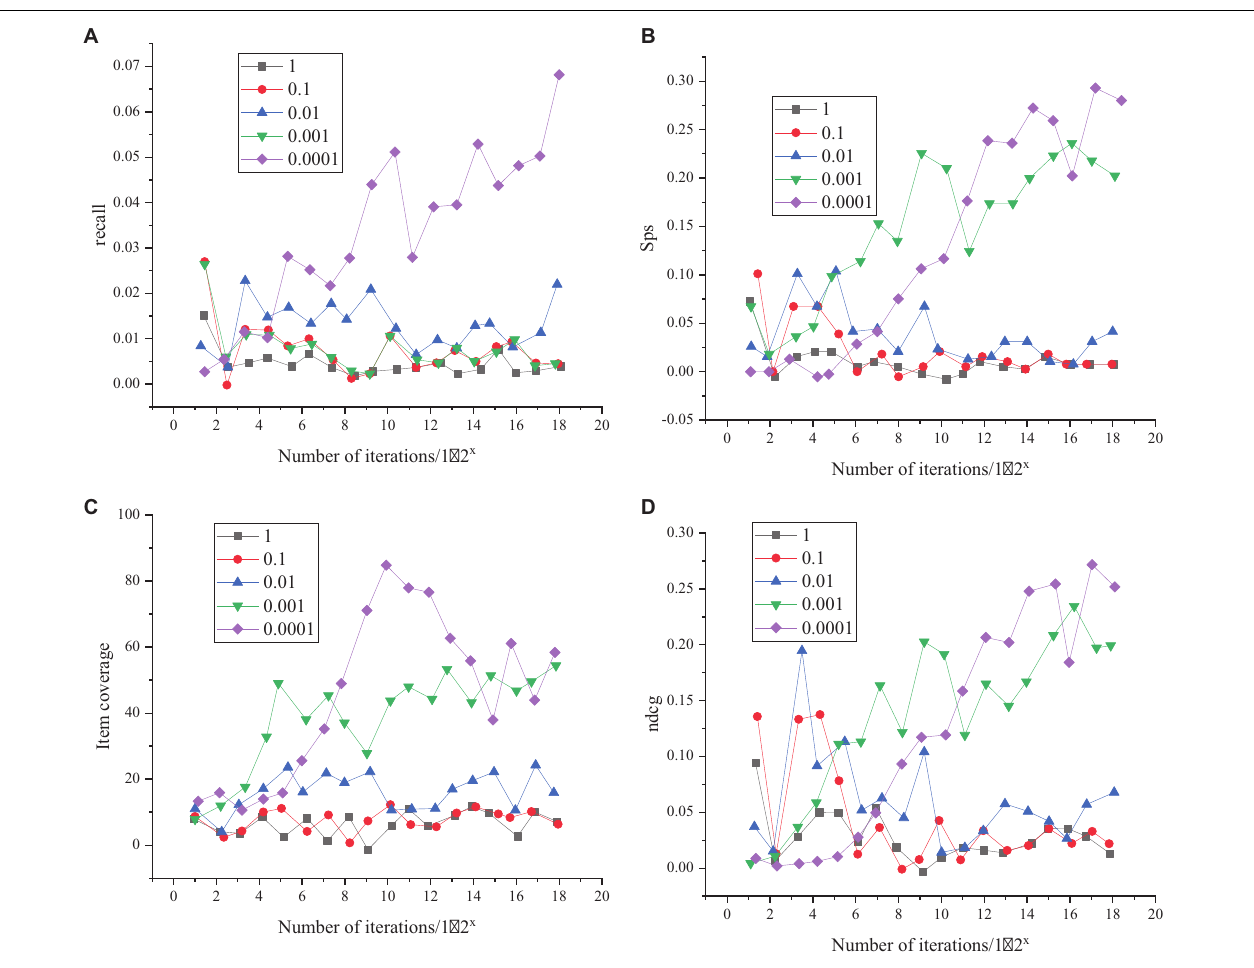
FIGURE 5 | Learning rate parameter selection results (A) represents the comparison results of recall under different learning rates, (B) indicates the comparison results of SPS values under different learning rates, (C) denotes the comparison results of item coverage under different learning rates, and (D) is the comparison results of item recommendation quality under different learning rates, represented by